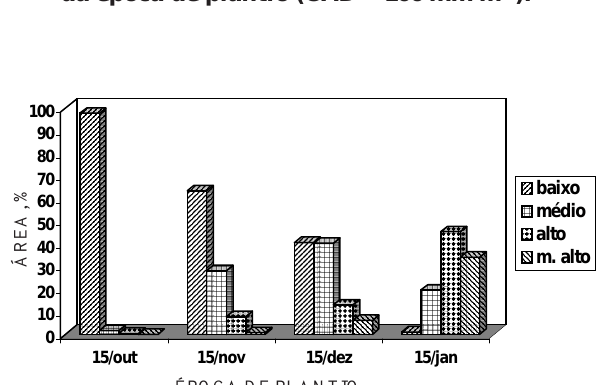
Figura 2. Alteração do grau de limitação por deficiência hídrica das terras, com o avanço da época de plantio (CAD = 100 mm m -1 ).